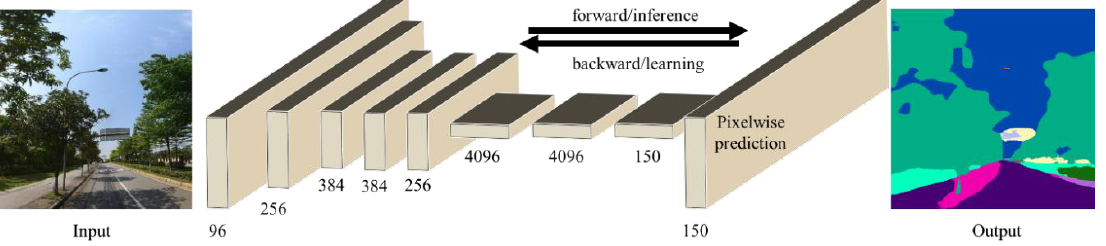
Figure 3. Street view image segmentation by a fully convolutional network (FCN-8s). In each sampling point, streetscape green space represents the ratio of the number of green space pixels per image summed over the four directions to the total number of pixels per image summed over the four directions. Then, the data of points were aggregated to the neighborhood